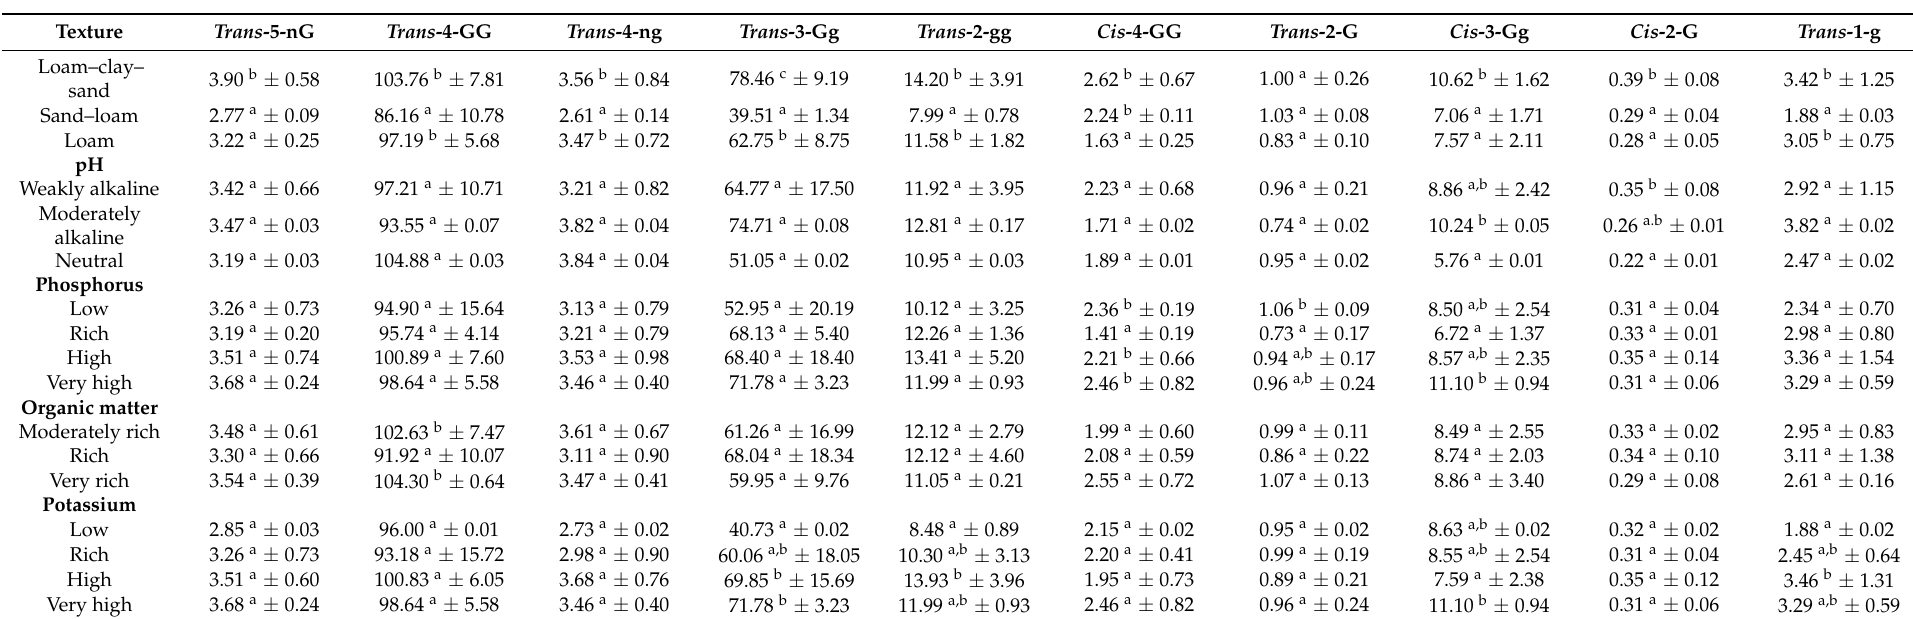
Table 2. Effect of soil texture, pH, mineral elements and organic matter on the crocetin esters (g kg − 1 of dry matter) of Moroccan